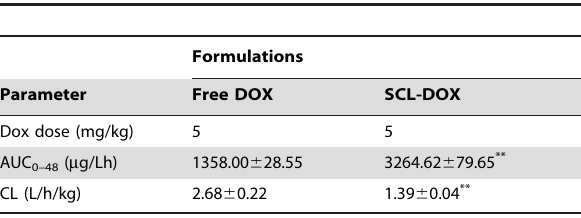
Table 2. Comparison of pharmacokinetic parameters of free DOX and SCL-DOX in SD Rats.